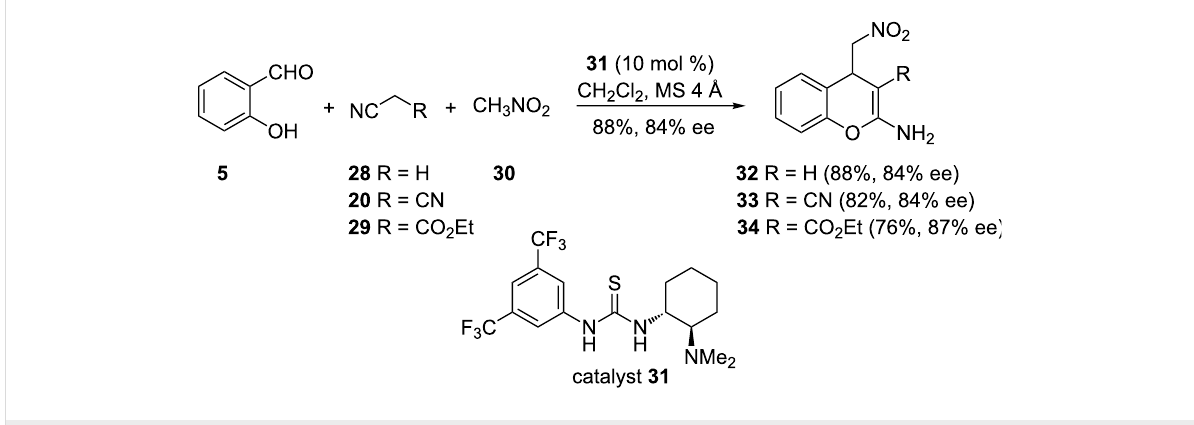
Scheme 11: Enantioselective synthesis of 2-aminochromenes 32 – 34 by Yang and